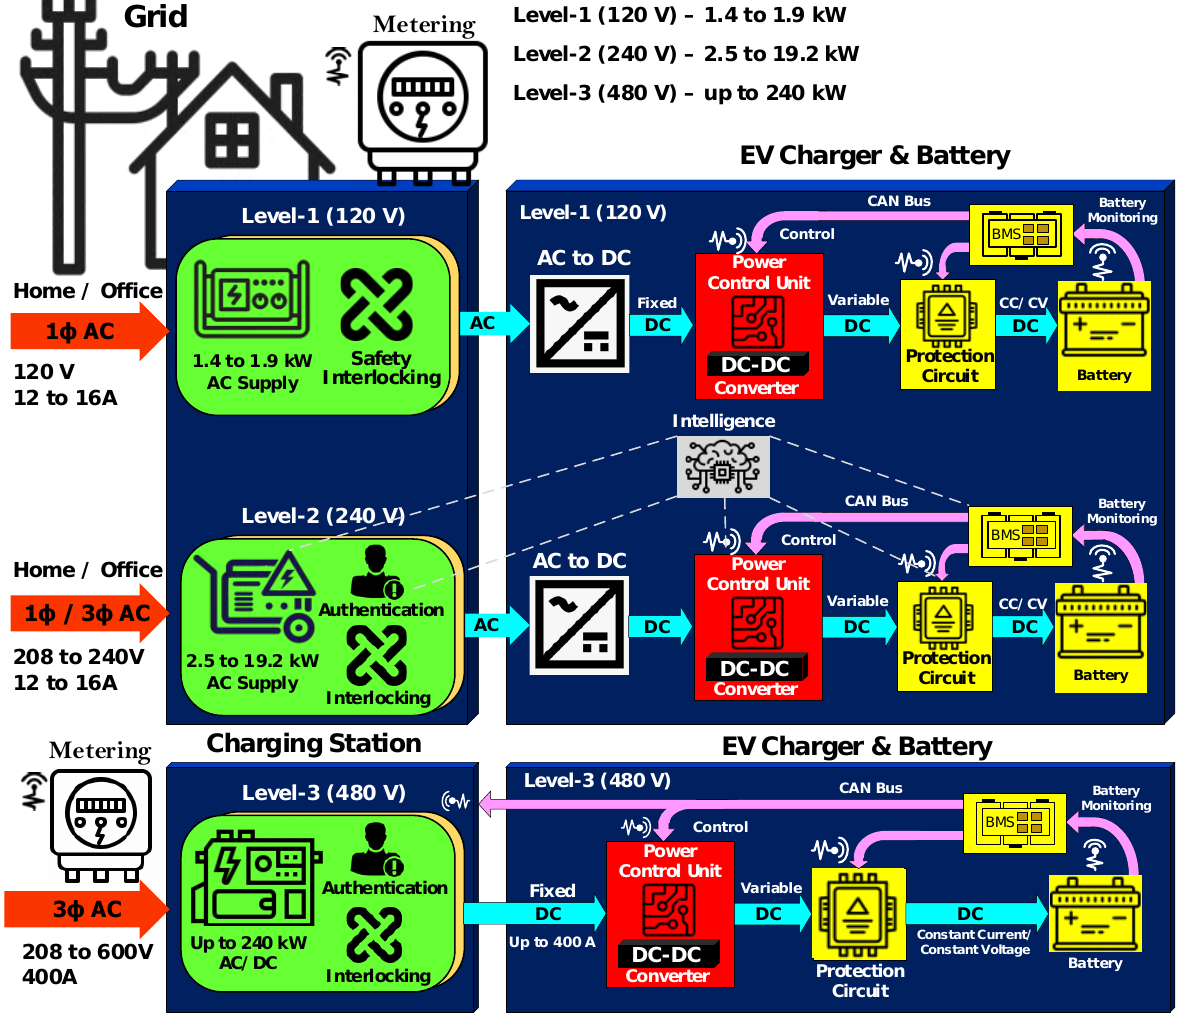
Figure 4. Communications model of different charging modes.